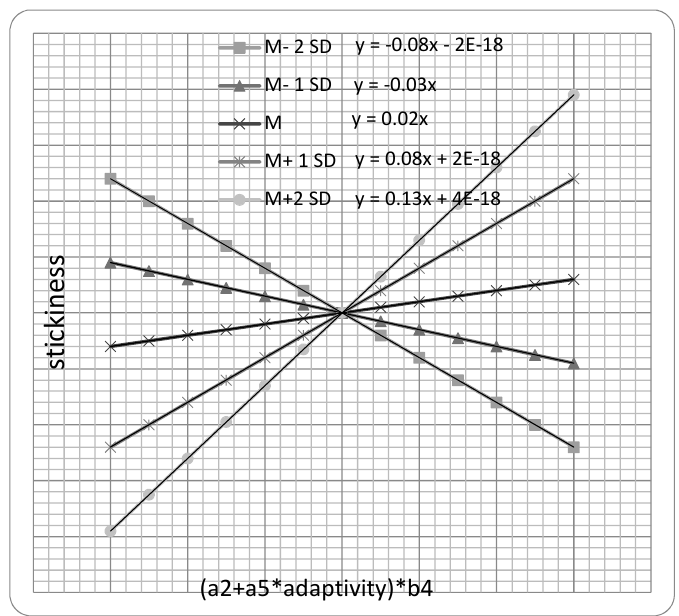
Figure 3. The effect of moderated mediation (perceived ease of use - > emotional connection - > stickiness). Table 3. Moderated mediation analysis (log likelihood = − 13,544.484, estimation method = ML). Independent Variable